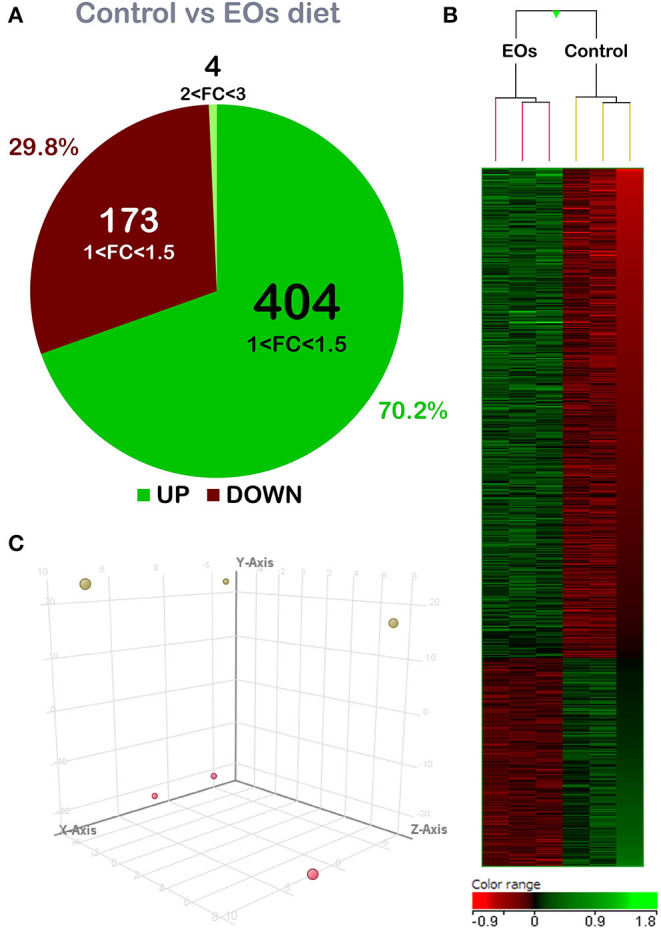
Differential expression analysis of the gilthead seabream (Sparus aurata) mid-anterior intestine transcriptomic response to the garlic, carvacrol, and thymol essential oils (EOs)-supplemented diet. (A) Comparing both groups, 581 differentially expressed genes (DEGs) (p < 0.05) were found. From these, 408 genes were upregulated: 404 mainly concentrated in the 1.0–1.5-fold change (FC) interval; and 4 DEGs were grouped in the 2.0 ≤ FC ≤ 3.0 interval. Additionally, 173 genes were downregulated (p < 0.05) and grouped in the range −1.5 ≤ FC ≤ −1.0. (B) Hierarchical clustering of the gilthead seabream mid-anterior intestine transcriptomic response for the control diet and EOs-supplemented diet, based on similitude patterns of the DEGs detected from three sample pools per dietary group. Data of the six microarrays are depicted, one for each represented pool. Both increased and decreased gene expression patterns are shown in green and red, respectively. All transcripts represented are statistically significant (p < 0.05). (C) Principal component analysis (PCA) of the DEGs of gilthead seabream intestine response to the control diet (yellow) and EOs-supplemented diet (red). PC1, PC2, and PC3 components loadings (Y-axis = component 1, 79.03% of variation; X-axis = component 2, 6.26% of variation; Z-axis = component 3, 6.03% variation). For DEGs details, please see also Supplementary Table 1.